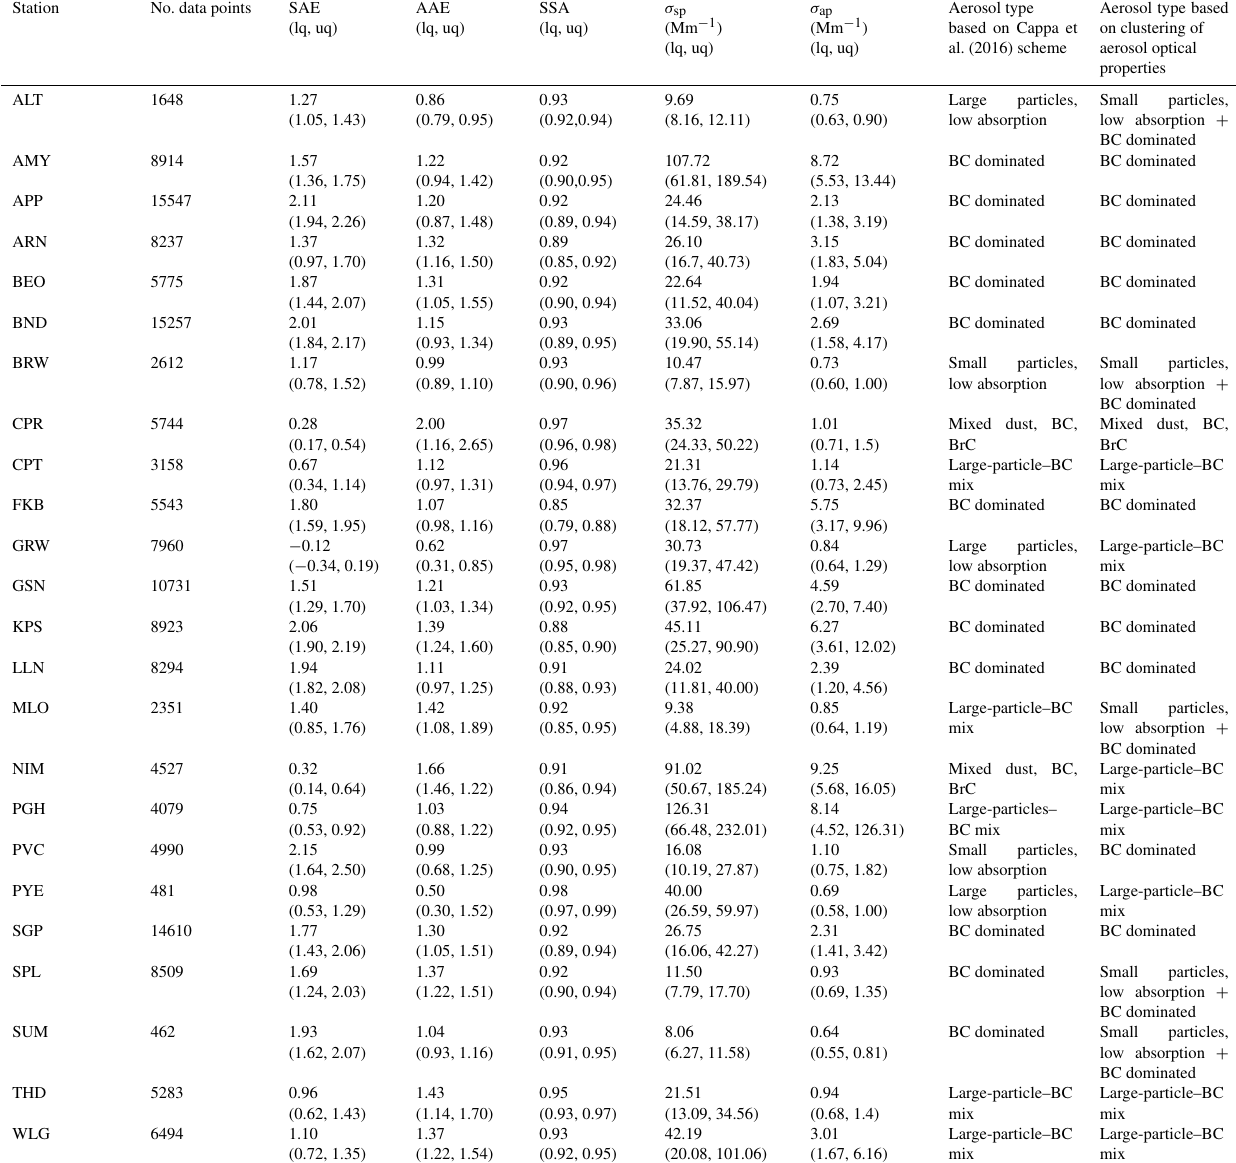
Table 3. Number of hourly data points, plus median values and lower and upper quartiles for scattering Ångström exponent and absorption Ångström exponent, single scattering albedo, scattering coefficient ( σ sp ), absorption coefficient ( σ ap ) and inferred aerosol type at each monitoring station. All data are filtered by thresholds σ sp >1Mm − 1 and σ ap >0.5Mm − 1